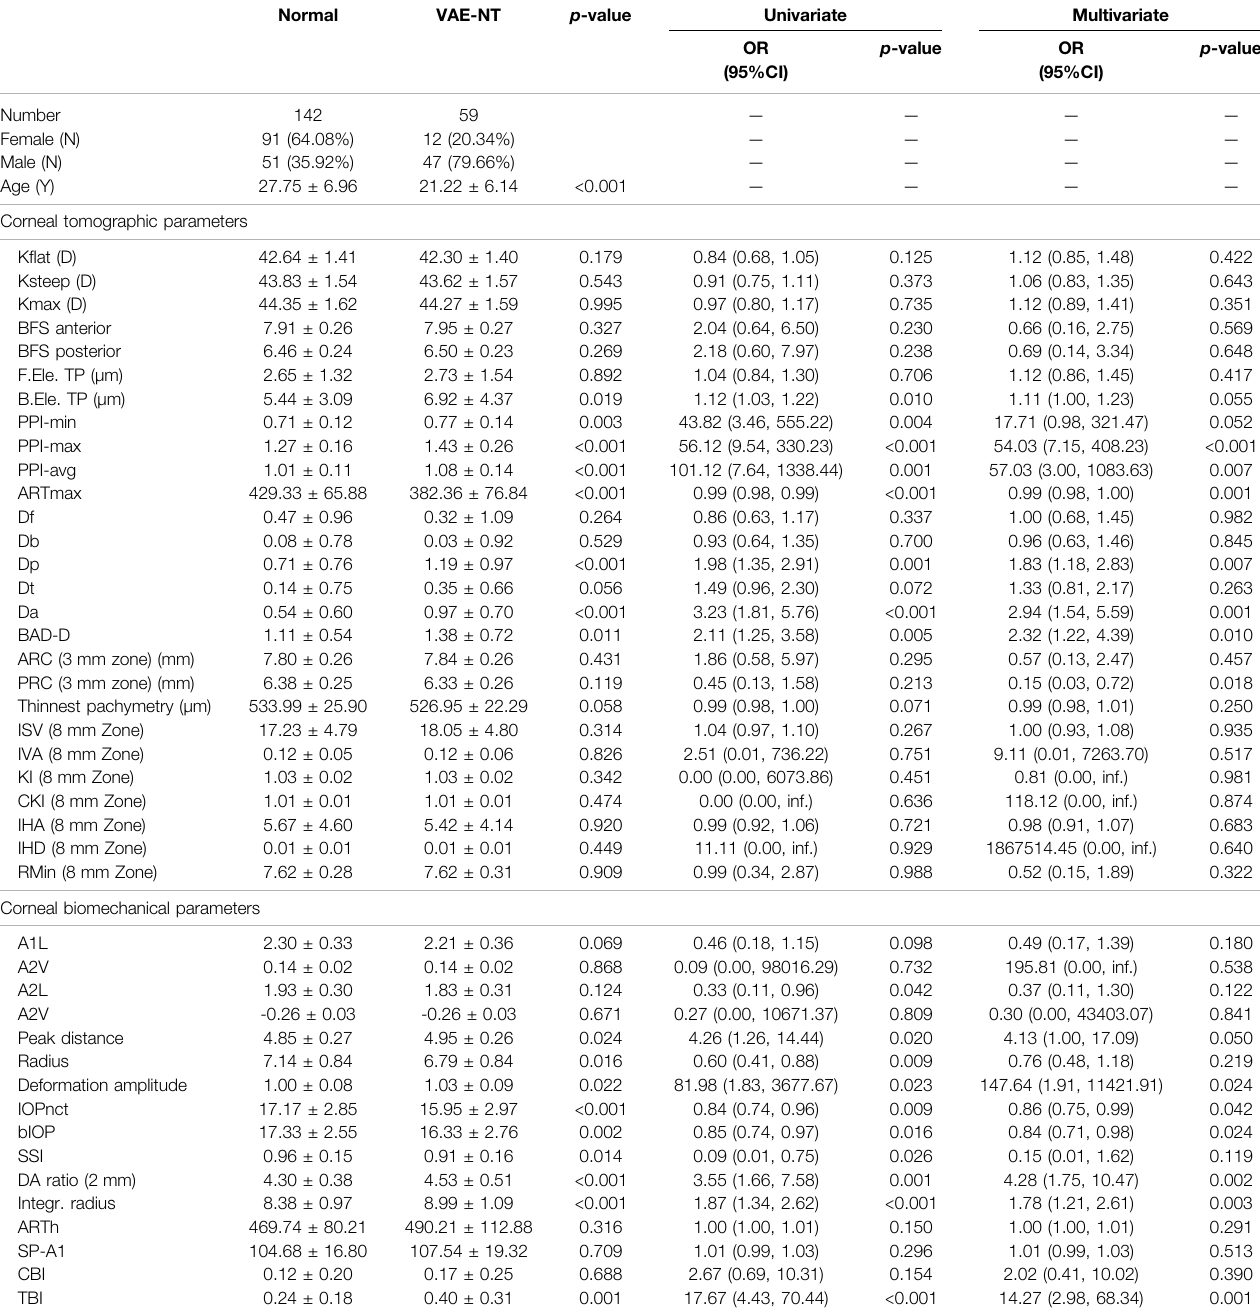
TABLE 1 | Corneal tomographic and biomechanical parameters and clinical characteristics for normal and VAE-NT